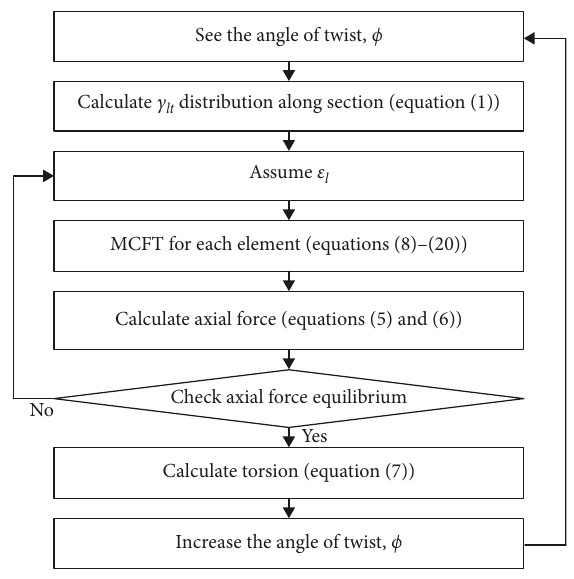
Figure 9: Analysis